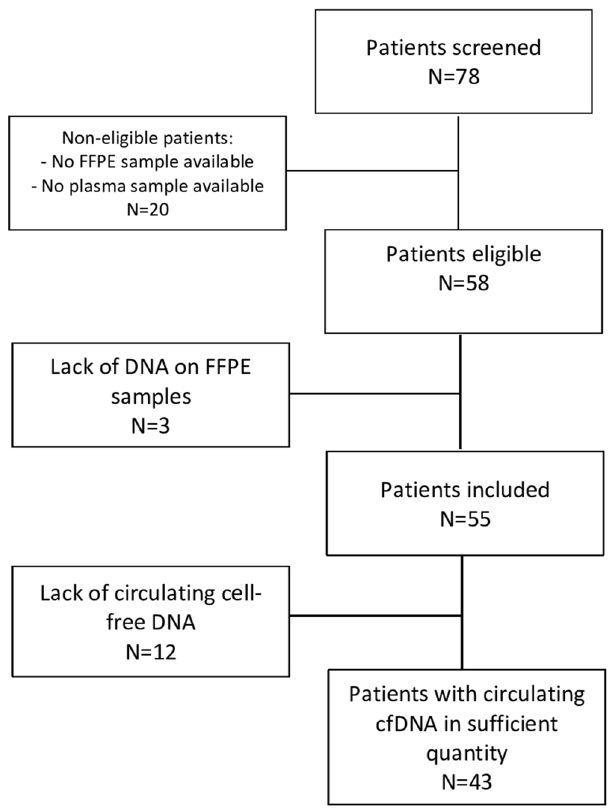
Figure 1. CONSORT diagram. Among the 78 patients screened, 20 were non-eligible because of non-available FFPE samples or plasma samples. Among them, 3 had a lack of DNA on FFPE samples and 55 patients were included. Finally, there was a lack of circulating cell-free DNA for 12 patients with 43 patients with circulating cfDNA in sufficient quantity.